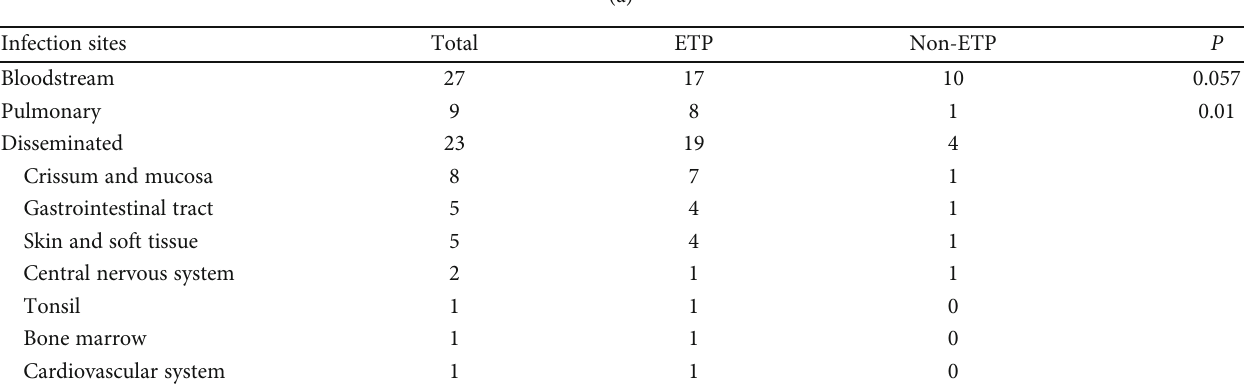
Table 2: Infection sites and causative agents of induction-related infections in PDT-ALL-LBL.